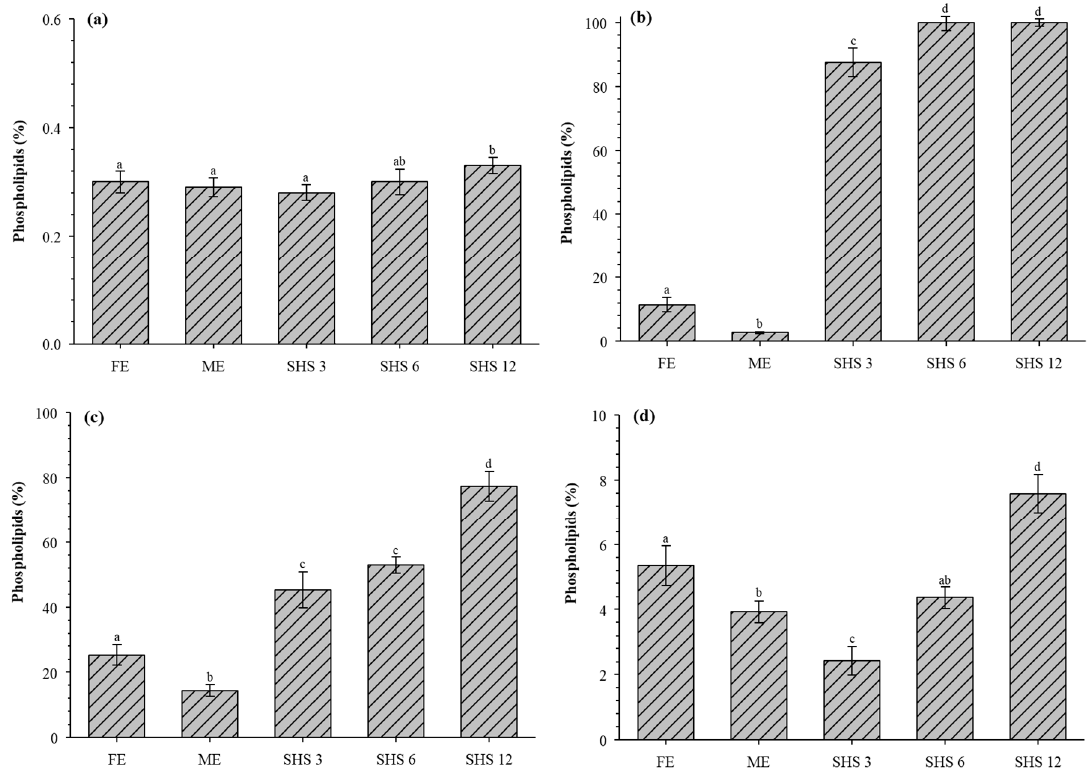
Figure 4. Comparison of different extraction methods (Folch, Mojonnier, and switchable hydrophilicity solvent) on the phospholipids recovered from ( a ) raw cream, ( b ) buttermilk, ( c ) concentrated buttermilk, and ( d ) beta-serum. FE: Folch extraction; ME: Mojonnier extraction; SHS 3, 6, 12: switchable hydrophilicity solvent ratio 1/3, 1/6, 1/12, respectively. Mean ± standard deviation within each column with different letters ( a – d ) are significantly different ( p < 0.05) according to Tukey test.